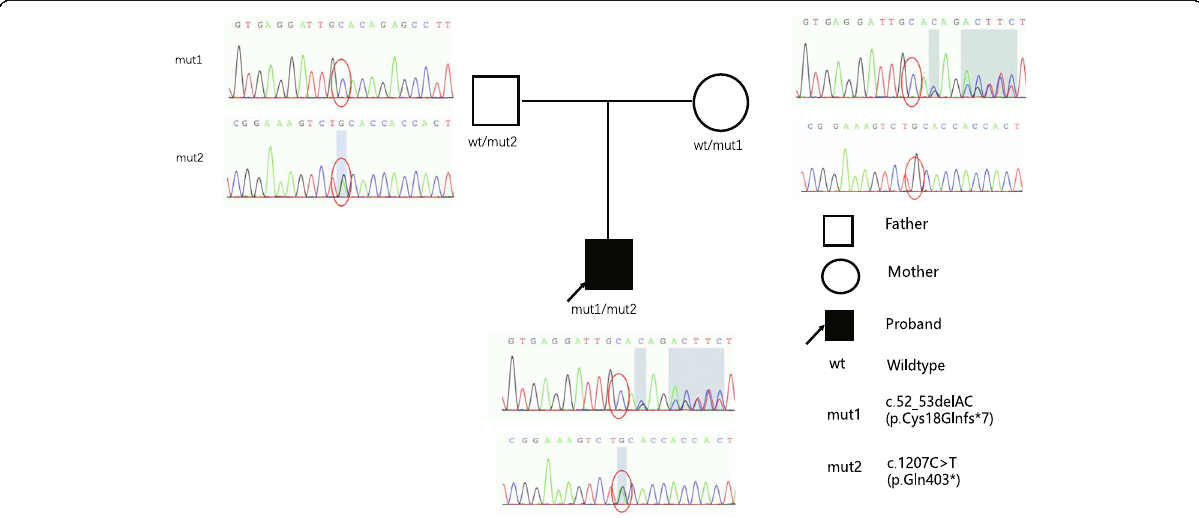
Fig. 2 Whole-exome sequencing (WES) and Sanger sequencing revealed compound heterozygous truncating variants c.1207C> T (p.Gln403*), c.52_53delAC (p.Cys18Glnfs*7)) in AP4B1 (NM_001253852.2). Electrochromatograms illustrated the variants in patient (arrow) and his parents. wt,